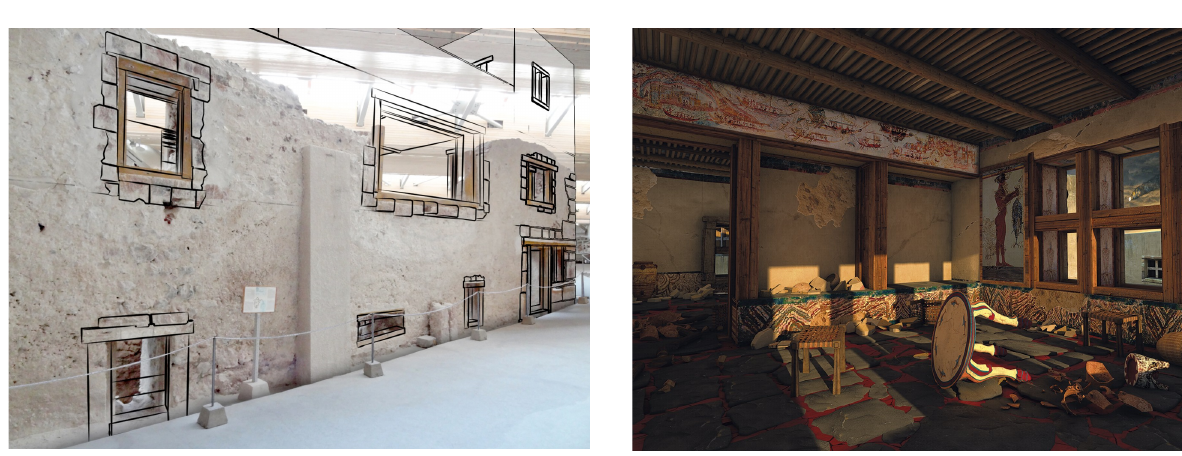
Figure 12: Atmospheric virtual reconstruction and artist impres- been found inside this